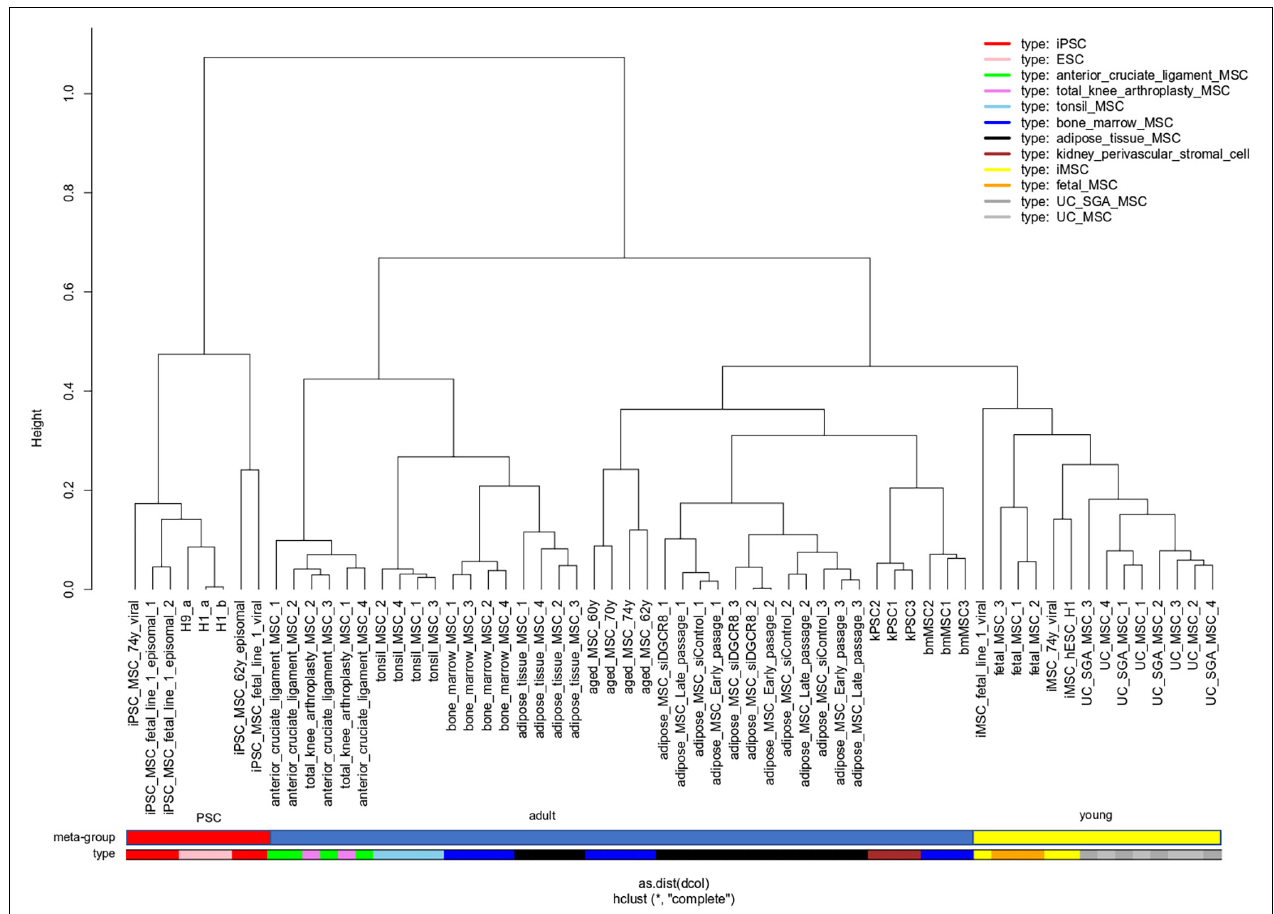
FIGURE 1 | “Young” MSCs cluster separated from adult MSCs and PSCs. Pluripotent stem cells (PSCs, red color bar) of embryonic or reprogrammed (iPSCs) origin cluster separated from MSCs. Within the MSCs one cluster contains all samples related to “young” origin: fetal MSCs, umbilical cord (UC) MSCs and iMSCs (derived from iPSCs), marked with a yellow color bar. Adult MSCs (blue color bar) of various origins are spread over the remaining